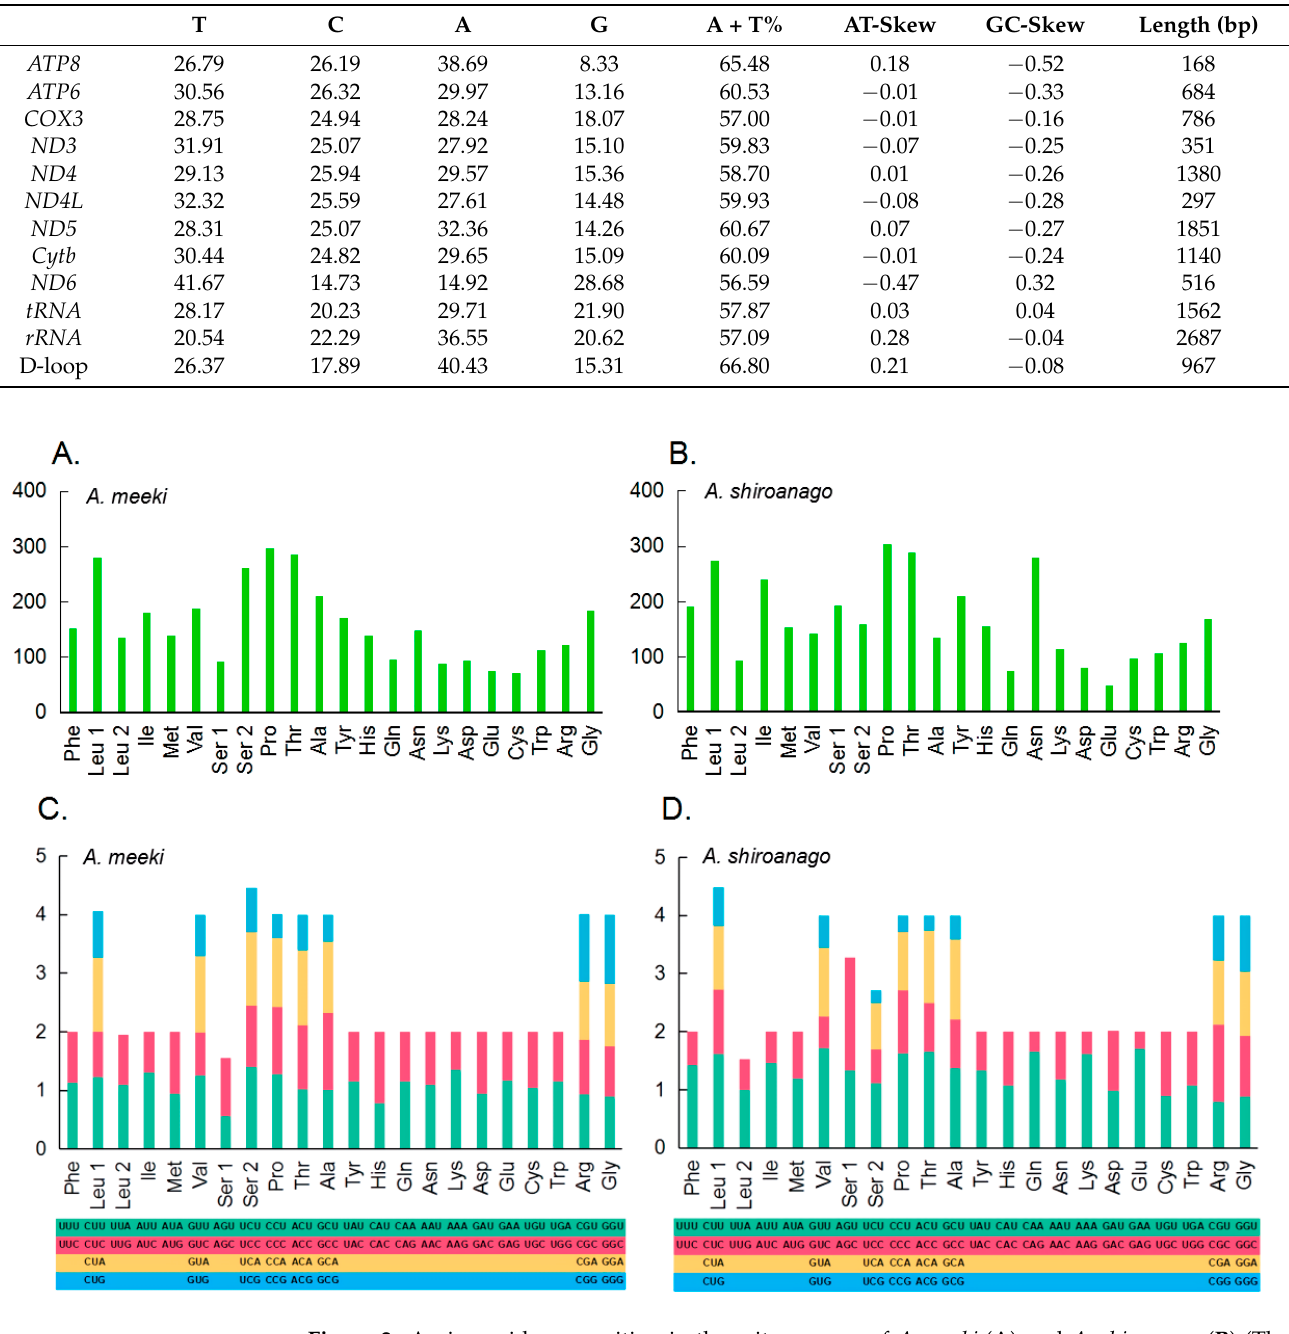
Figure 2. Amino acid composition in the mitogenome of A. meeki ( A ) and A. shiroanago ( B ) (The x- and y -axis refer to the amino acid composition and the number of each amino acid in 13 PCGs, respectively). Relative synonymous codon usage (RSCU) in the mitogenome of A. meeki ( C ) and A. shiroanago ( D ). (The y -axis represents the usage frequency of the corresponding amino acid codons in 13 PCGs. Different colors represent the different codons in the amino acids).